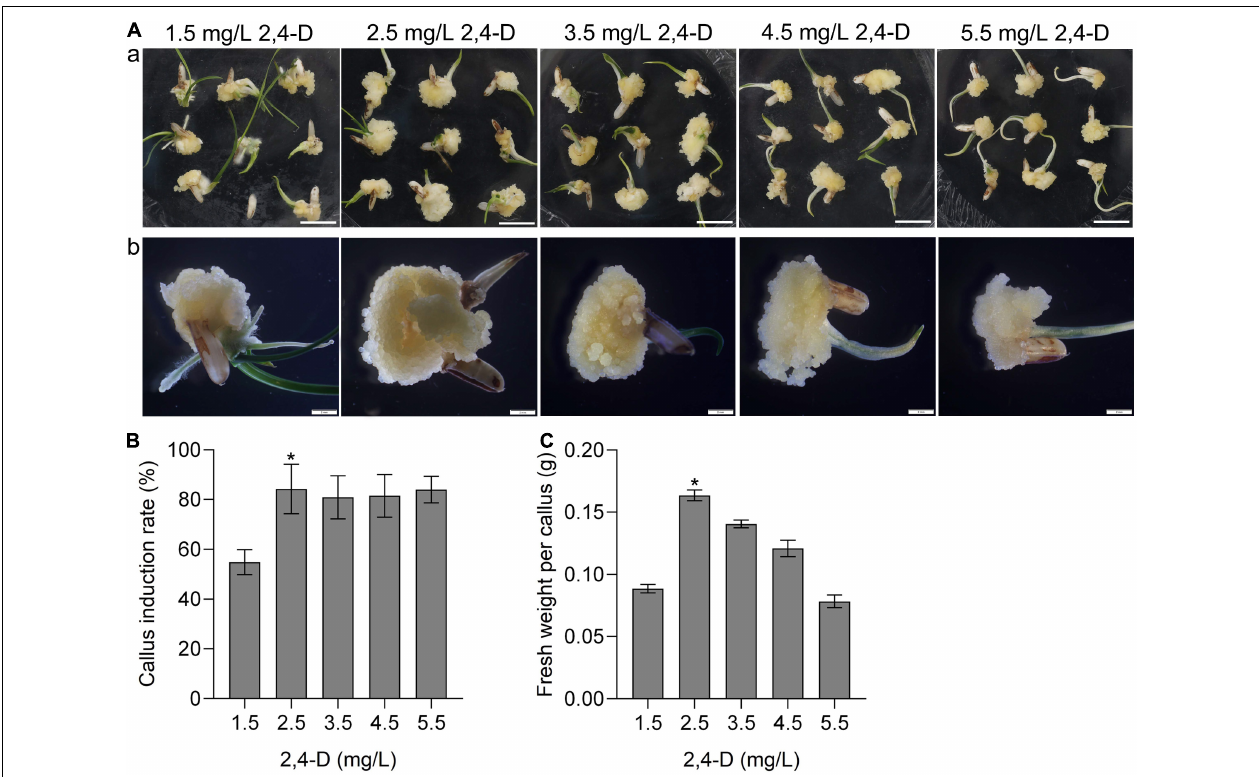
FIGURE 1 | Effects of different concentrations of 2,4-D on calli induction of CLCWR. (A) Calli of CLCWR induced on callus induction medium containing different concentrations of 2,4-D. (a) Calli were induced on callus induction medium containing 1.5, 2.5, 3.5, 4.5, and 5.5 mg/L of 2,4-D for 15 days by using scutellum tissue of embryos in mature seeds. Bars = 1 cm. (b) The calli induced by different concentrations of 2,4-D were enlarged by using the stereomicroscope. Bars = 2 mm. (B) Callus induction rate of CLCWR. The callus induction rates were calculated after inducing for 15 days. (C) Fresh weight of CLCWR calli referred to (A) . Significant differences were found between 2.5 and 1.5, 3.5, 4.5, and 5.5 mg/L of 2, 4-D (* P < 0.01 by Student’s t- test). Data are means of three replicates of one experiment. The experiment was repeated three times with similar results. Error bars represent ± SD. Asterisks represent significant